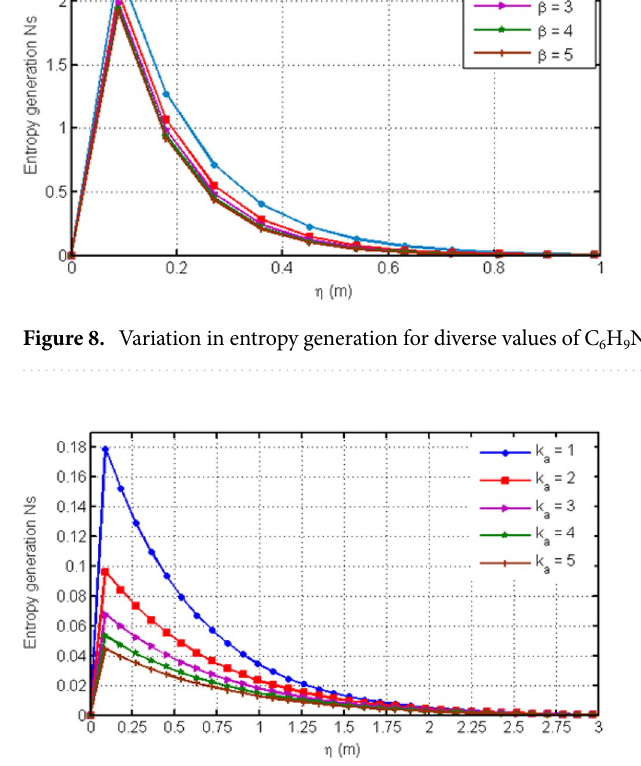
Figure 9. Variation in entropy generation for diverse values of porosity parameter Ka.